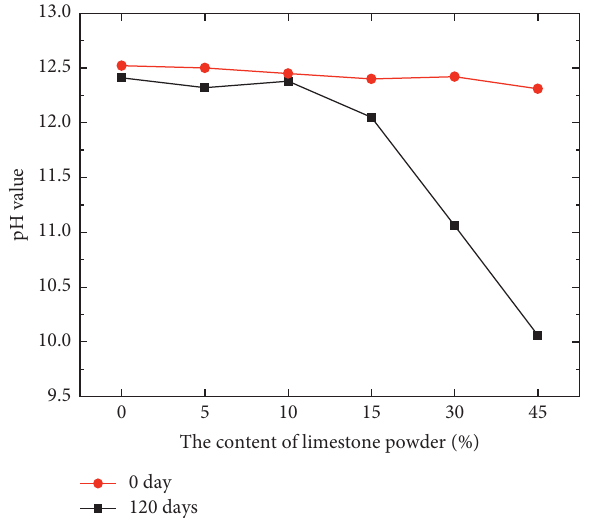
Figure 14: pH of the cathode surface for all the samples at 120 days.